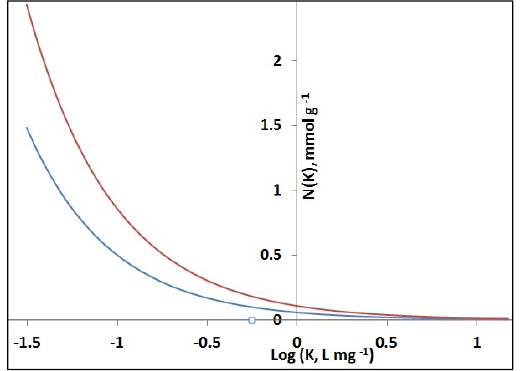
Figure S3. Affinity distributions corresponding to Freundlich Isotherm binding model [31] for MIP 5 on PETA ( ) and corresponding NIP ( ) calculated based on binding parameters (Formula